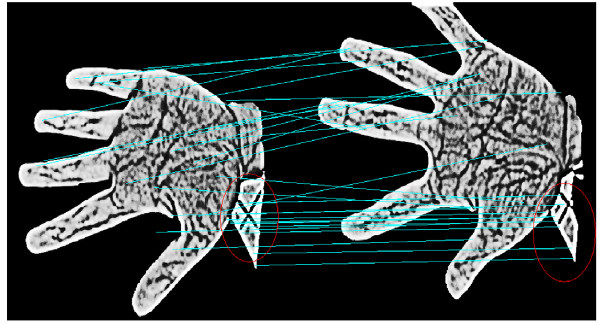
Figure 2. Feature matching before cropping the palm region near the